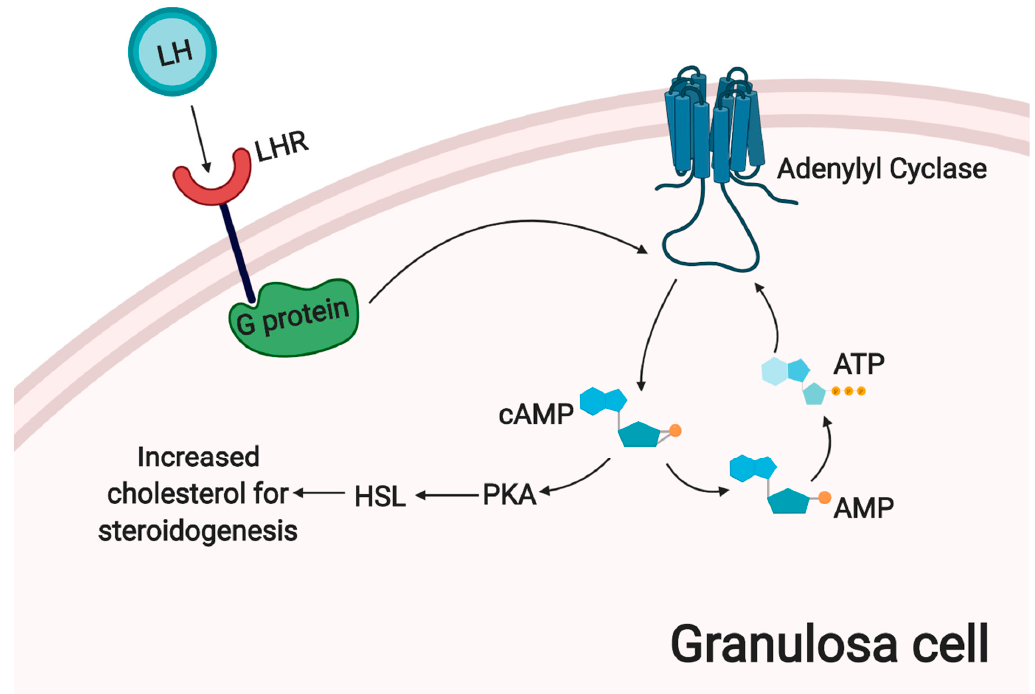
Figure 3. Steroidogenesis in the corpus luteum.